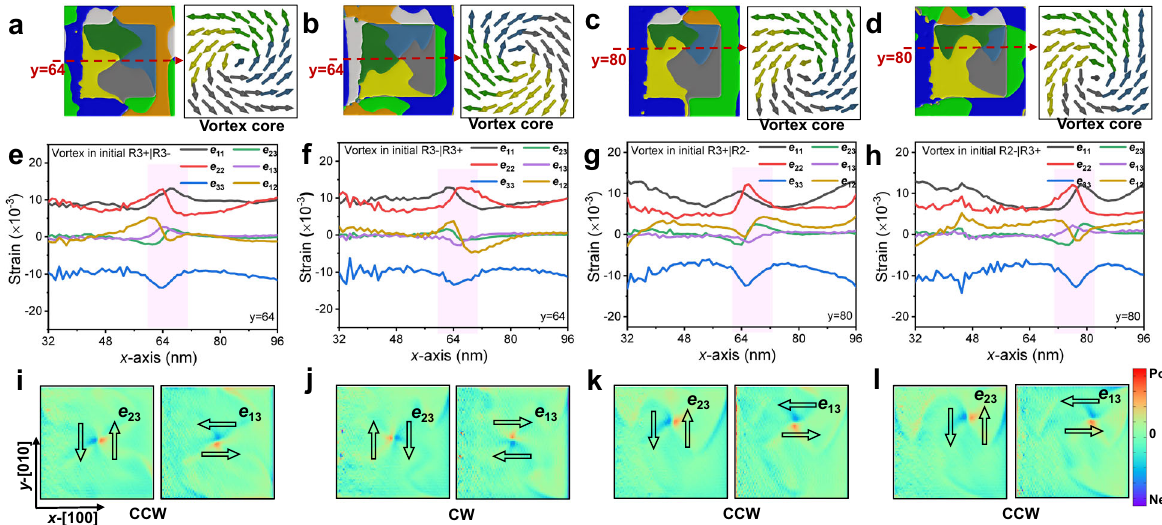
Fig. 5 The elastic strain ( e 11 , e 22 , e 33 , e 23 , e 13 , e 12 ) distribution in the vortex domain. a – d The vortex structure and the enlarged core polarization vector map are viewed in x – y cross-section. e – f The strain distribution in chiral vortex along the red dashed line in a – d , respectively. i – l The distribution of shear strain ( e 23 , e 13 ) in the chiral vortex, respectively. The arrows indicate the shear strain